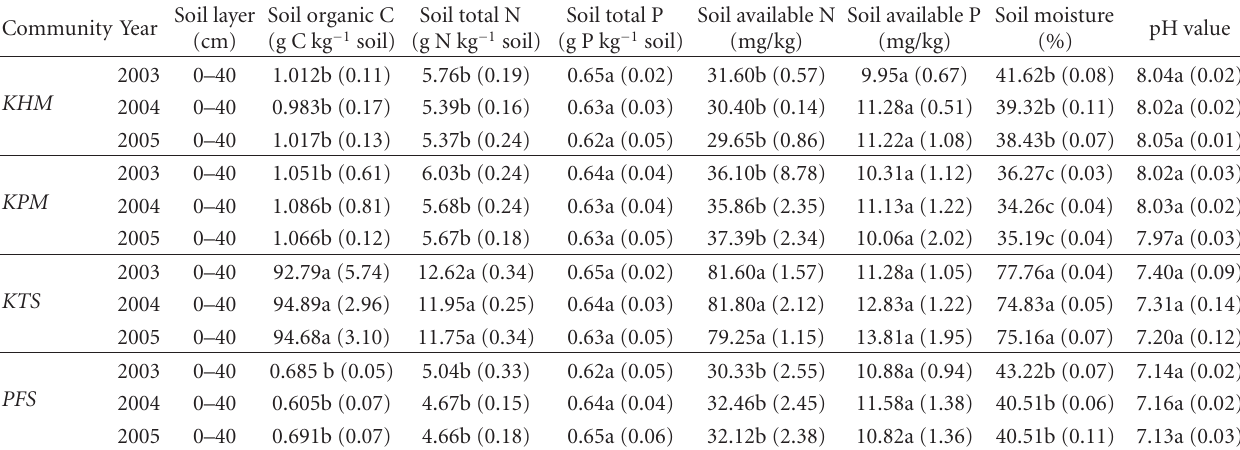
Table 1: Chemical properties of soil samples collected in four alpine meadow plant communities (Mean ± SD). Numbers in parentheses indicate standard deviation ( n = 6). Data from di ff erent communities at same year followed by the same letters were not significantly di ff erent at 0.05 levels (Duncan’s multiple range tests). C mic : Microbial biomass C, Q mic : Soil microbial quotient. Kobresia humilis meadow =